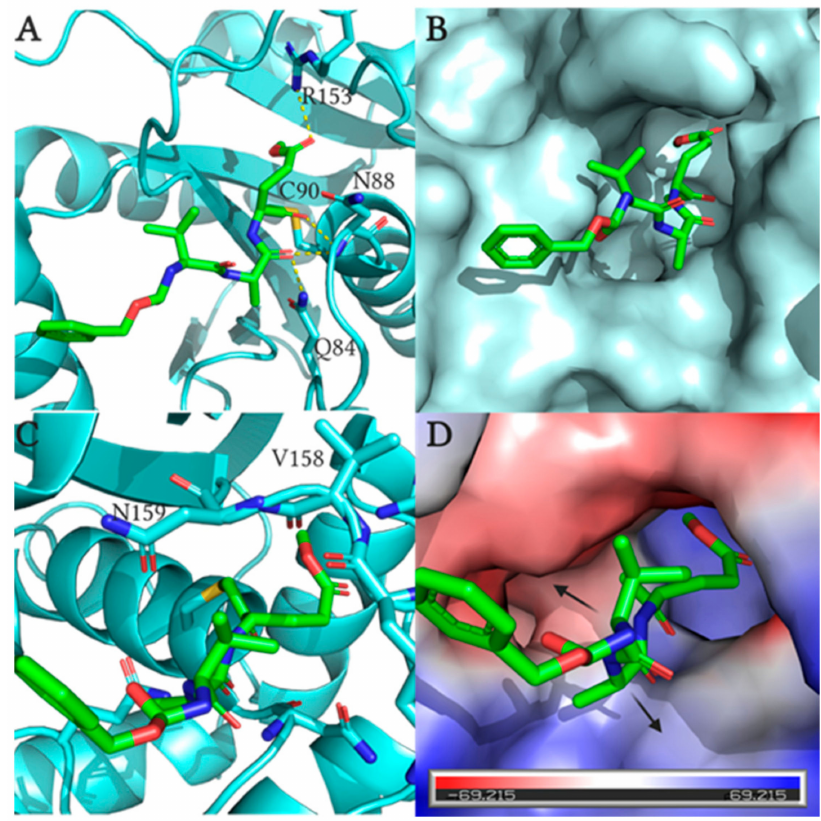
Figure 3. Crystal structure of VAEFMK 1 (green sticks) bound to UCHL1 (cyan). ( A ) VAEFMK contacts (yellow dashed line) with critical residues in UCHL1 active site. ( B ) Surface representation of VAEFMK binding pose in UCHL1 active site. ( C ) Point of view depicting that valine in VAEFMK is directed toward cross-over loop amino acid residues Val158 and Asn159. ( D ) Electrostatic surface map representation with VAEFMK bound (generated in PyMol). Red regions indicate negative surface charge and blue indicates positive surface charge. Arrows indicate the vector in which the D -amino acid side chains for valine and alanine would be directed from